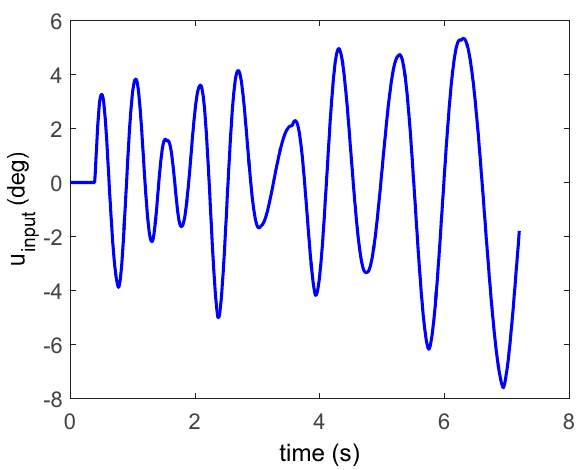
= corresponds to start of controller).